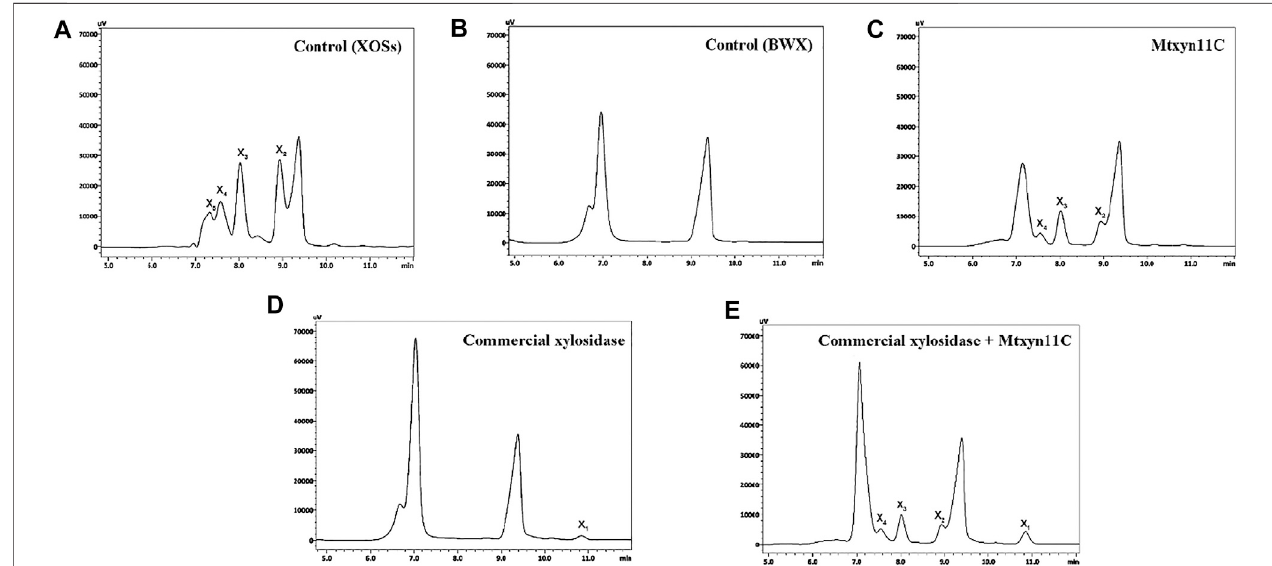
FIGURE 5 | HPLC pro fi le of hydrolyzed products of BWX by Mtxyn11C. (A) Control for the standards (XOS); (B) Control for BWX without adding an enzyme; (C) Degradation of BWX by Mtxyn11C (X 1 , xylose; X 2 , xylobiose; X 3 , xylotriose; X 4 , xylotetrose); (D) Degradation of BWX by commercial β -xylosidase; (E) Degradation of BWX by the combine action of Mtxyn11C and commercial β -xylosidase.